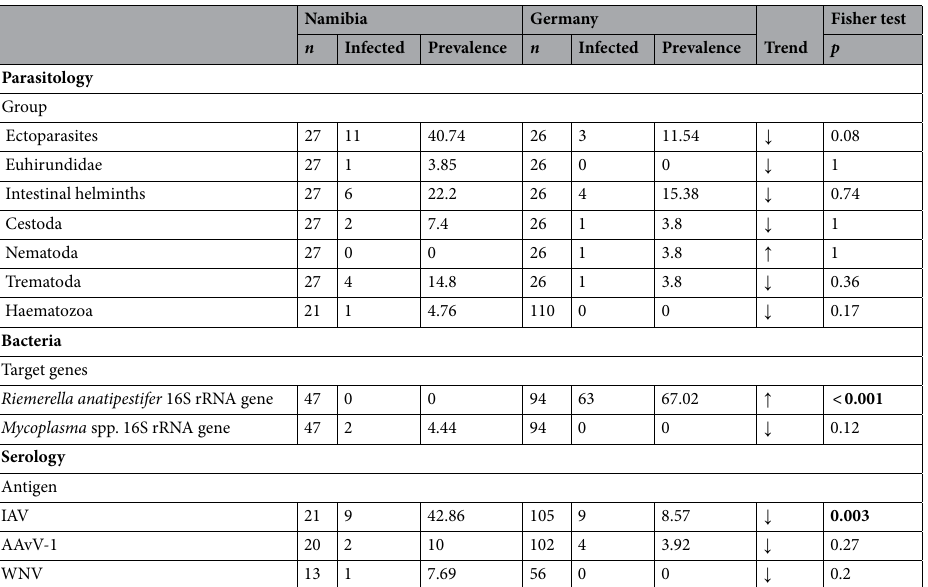
Table 2. Results of the parasite screening and serology of Egyptian geese from Namibia and Germany (adult geese from Prüter et al. 32 ). Total sample sizes ( n ), number of infected individuals (Infected) and prevalences (%) of macro-parasites, bacteria and seroprevalences against selected viruses in the native Namibian and invasive German population of Egyptian geese ( Alopochen aegyptiacus ); Trend: ↓ higher prevalence in the native than in the invasive population; ↑ higher prevalence in the invasive than in the native population; Outcome of Fisher’s exact test comparing prevalences of the two groups ( p -value < 0.05 is defined as significant and indicated in bold. IAV Influenza A virus, AAvV-1 Avian avulavirus 1 , WNV West Nile virus